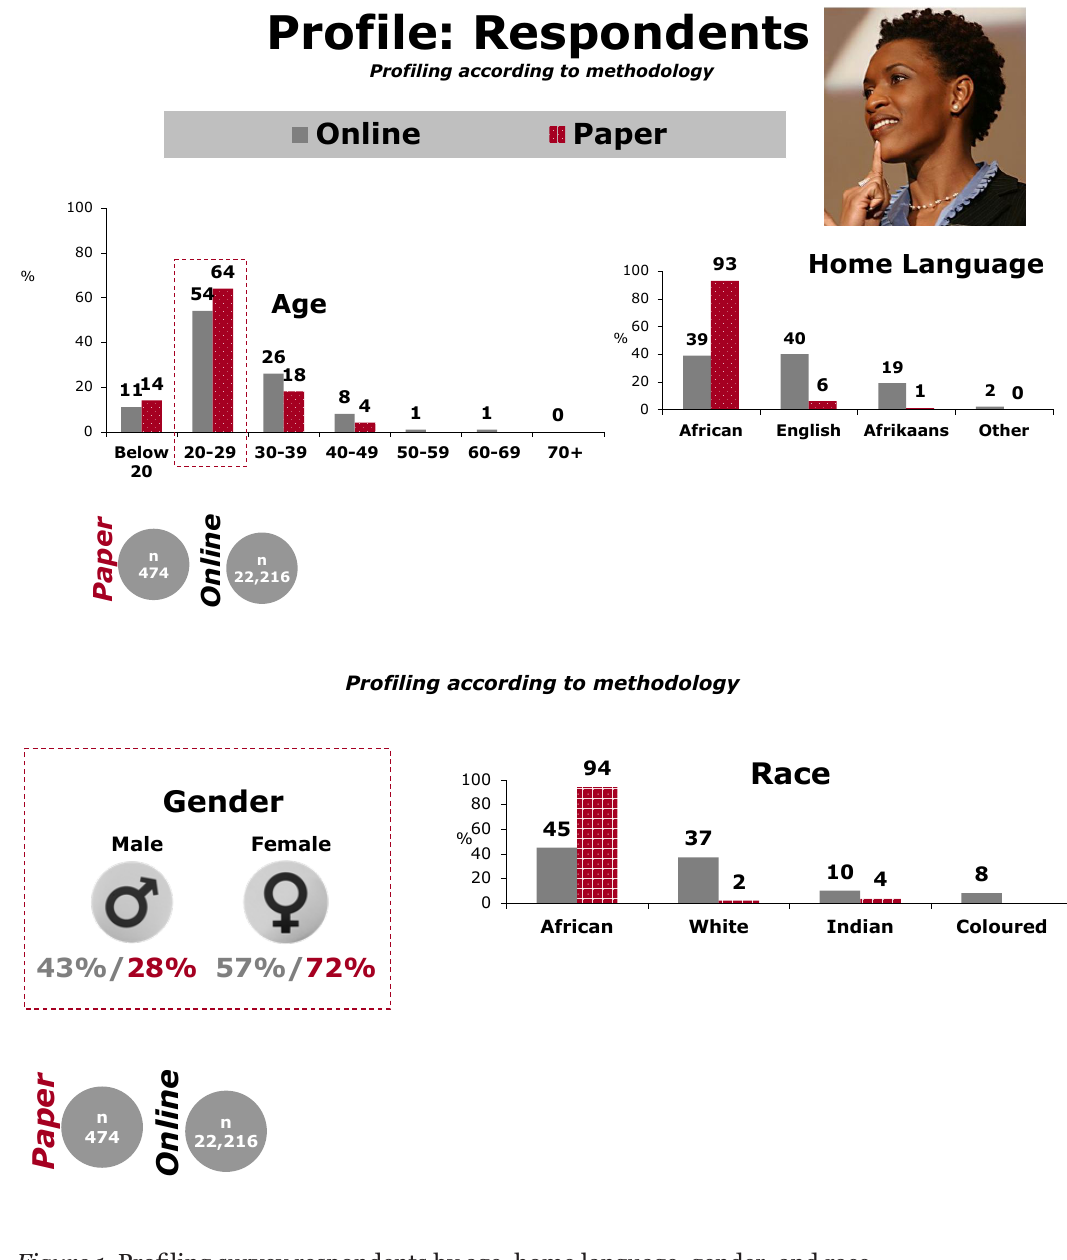
Figure 1. Profiling survey respondents by age, home language, gender, and race. The majority of participating students were African females, for both the online and the paper-based options, clearly representative of Unisa’s current student body, with the ma- jority of students falling into the above-mentioned